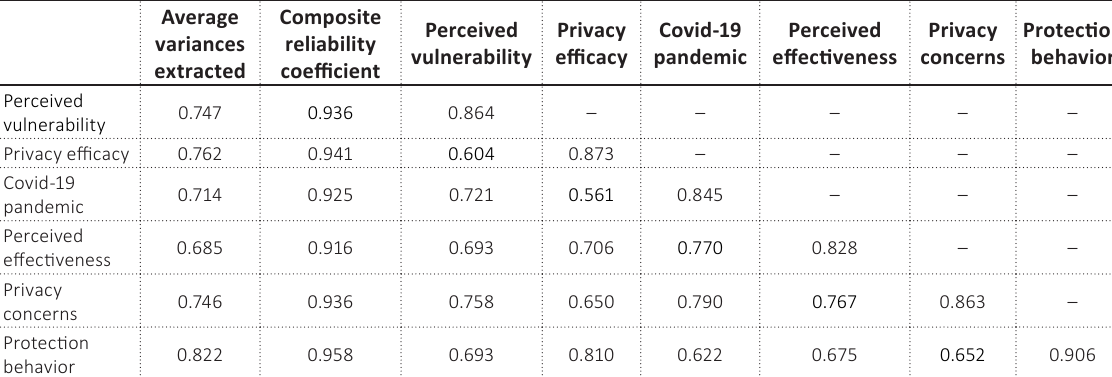
Table 1. Results of protection behavior